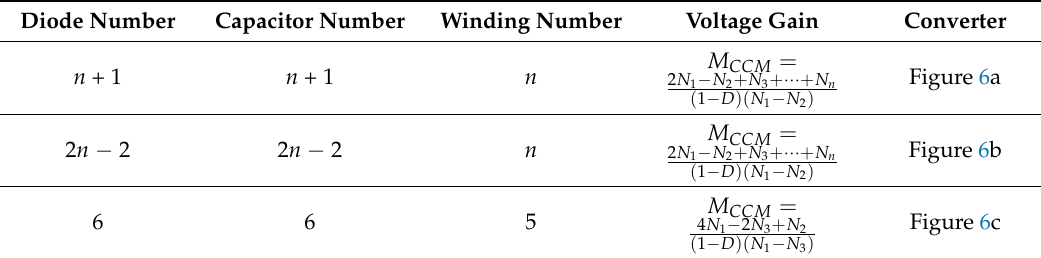
Table 3. System specifications of the proposed converter.